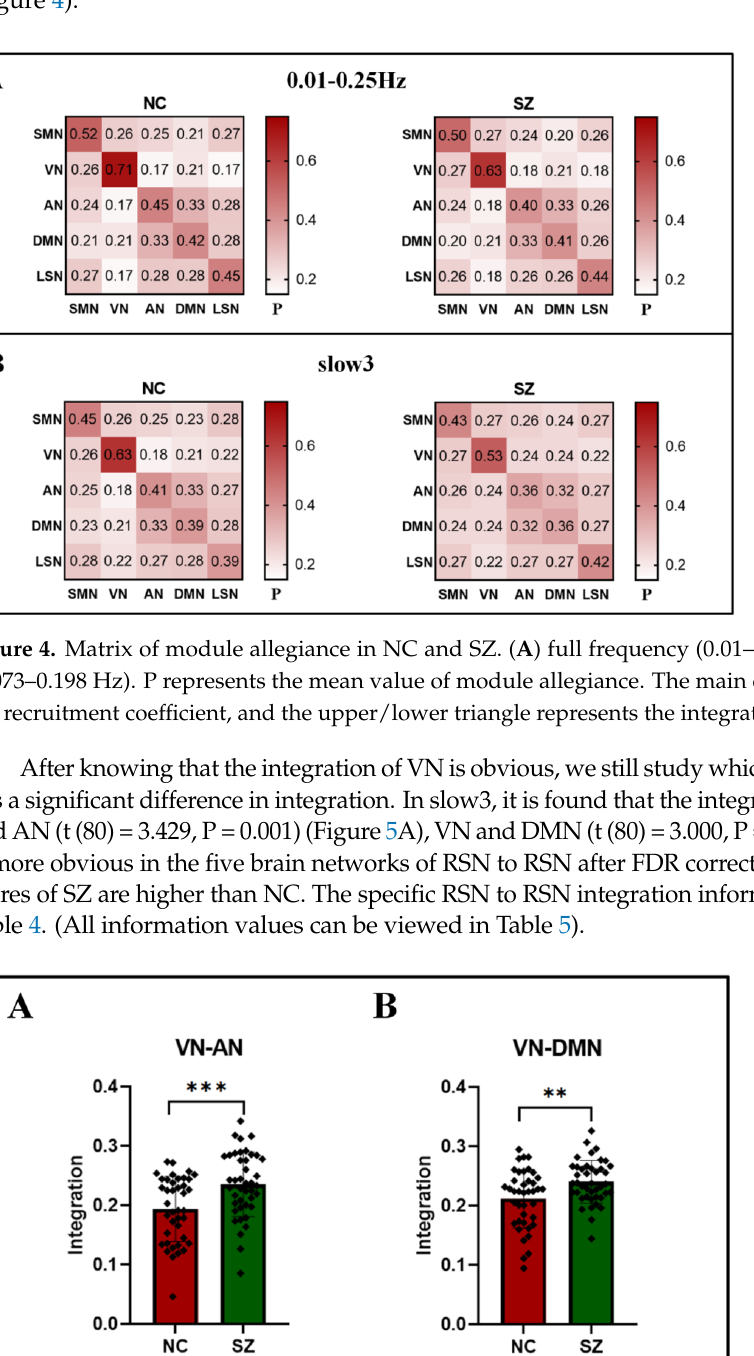
Figure 5. Group differences of integration for each pair of RSN to RSN in slow3 (0.073–0.198 Hz). ( A ) the integration between Visual network(VN) and Attention network(AN). ( B ) the integration between Visual network(VN) and Default mode network(DMN). Asterisk indicates pairwise group differences; *** denotes p < 0.001, ** denotes p <